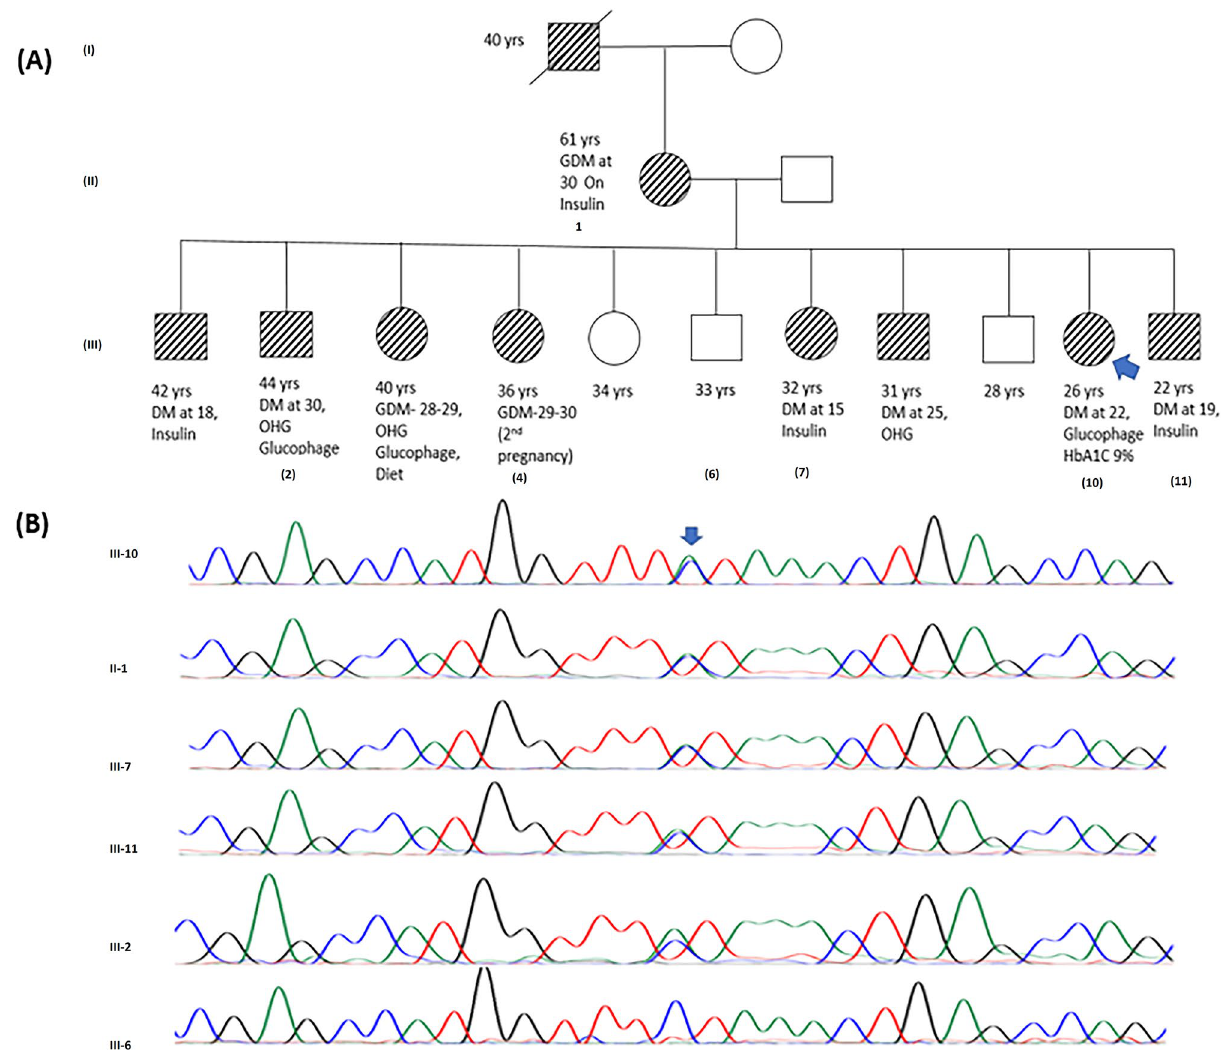
Figure 3. ( A ) Represents pedigree of a family positive for Maturity Onset Diabetes of the Young (MODY3). The square symbol represents male, and the circle represents female. The filled in symbols indicate affected individuals and the blue arrow indicates the index case. Next generation sequencing revealed a novel heterozygous missense variant in HNF1A, c.8C > A, resulting in p.Ser3Tyr. ( B ) Chromatogram represents Sanger sequencing results confirming the segregation of heterozygous variant in the index case, affected and unaffected family